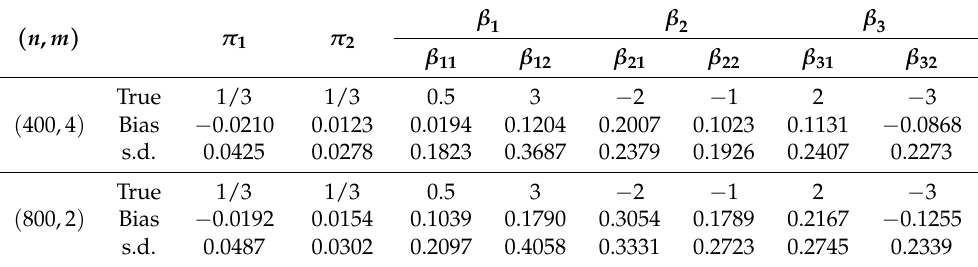
Table 2. The empirical bias and sample standard error (s.d.) of the estimators ˆ π 1 , ˆ π 2 , ˆ β based on 100 replications in Example